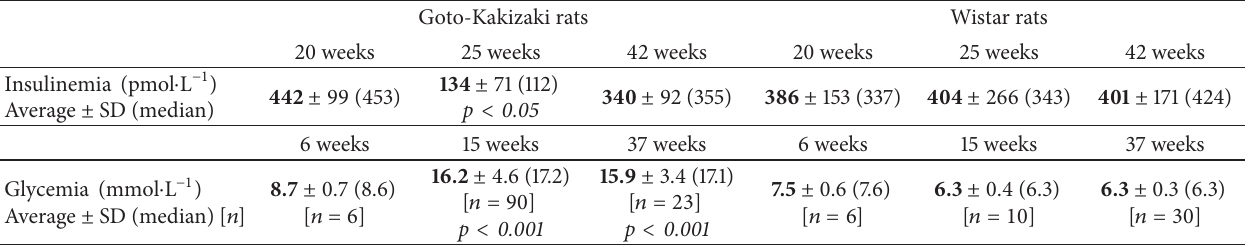
Table 1: Postprandial insulinemia in hyperglycemic rats and fasting glycemia in all rats within studied